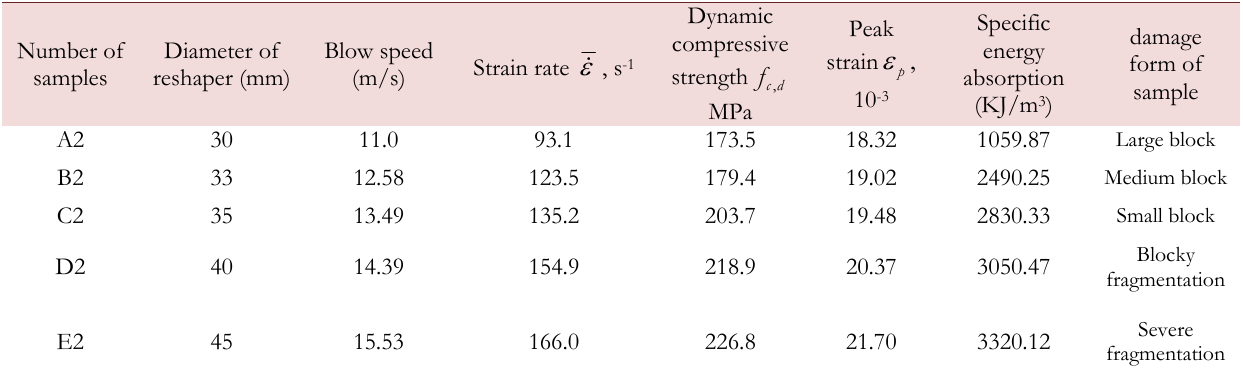
Table 4: SHPB experiment results of sandstone.